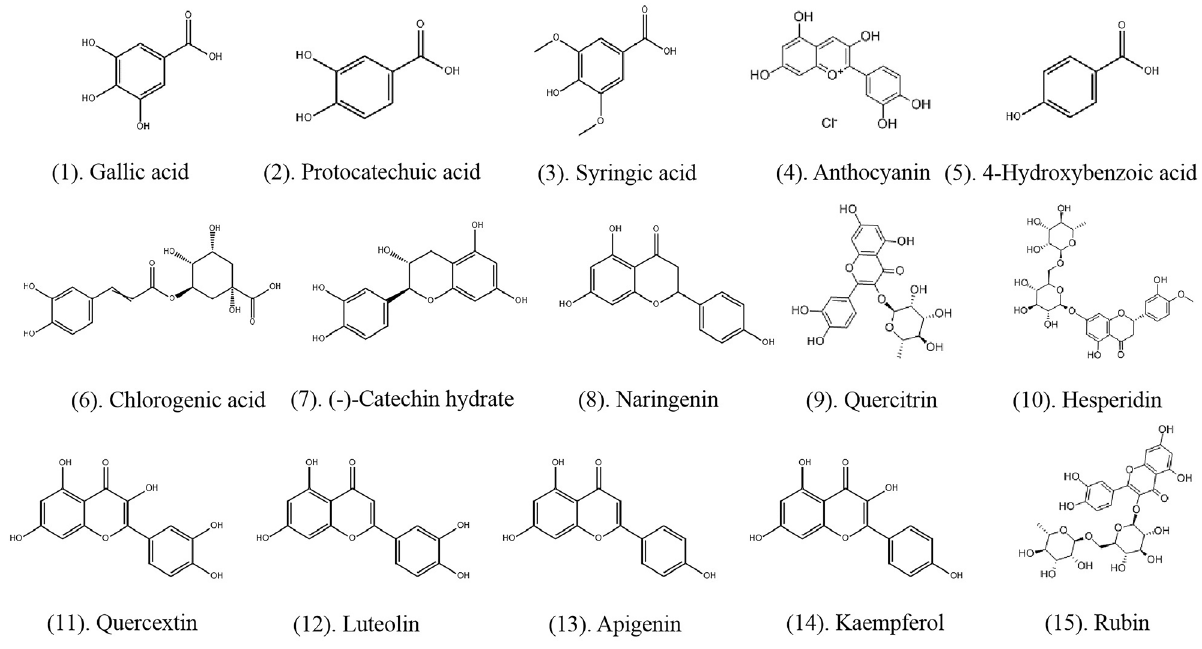
Figure 5. Structures of the main effective compounds in rose